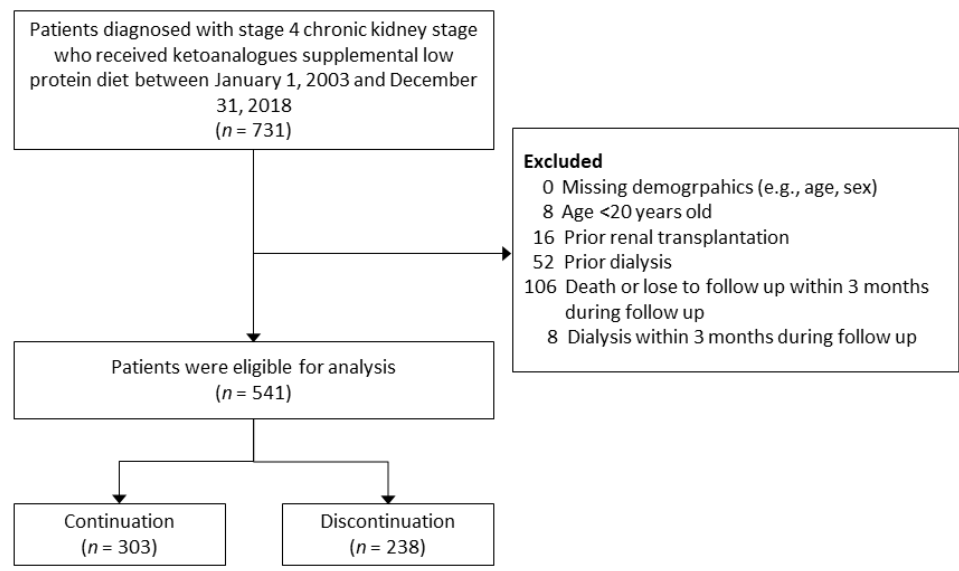
Figure 1. Flowchart for the inclusion and exclusion of the study patients.